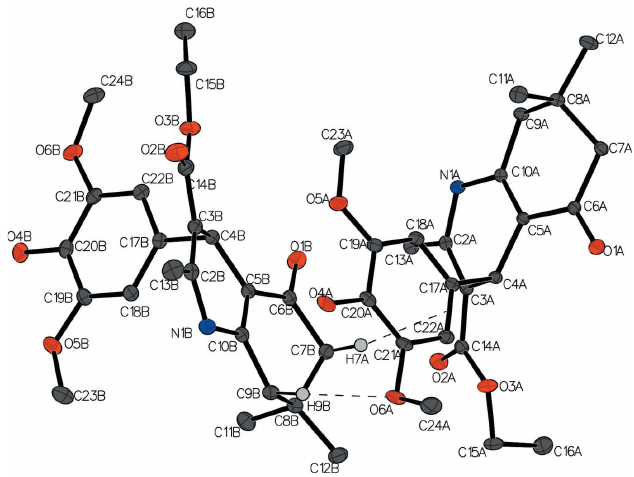
Figure 3 The asymmetric unit of compound II showing the atom-labeling scheme. Displacement ellipsoids are drawn at the 50% probability level. The dashed lines indicate the C9 B —H9 B (cid:2)(cid:2)(cid:2) O6 A hydrogen bond and the C— H (cid:2)(cid:2)(cid:2) (cid:2) interaction between H7 A and the C17 A —C22 A bond. Other hydrogen atoms have been omitted for